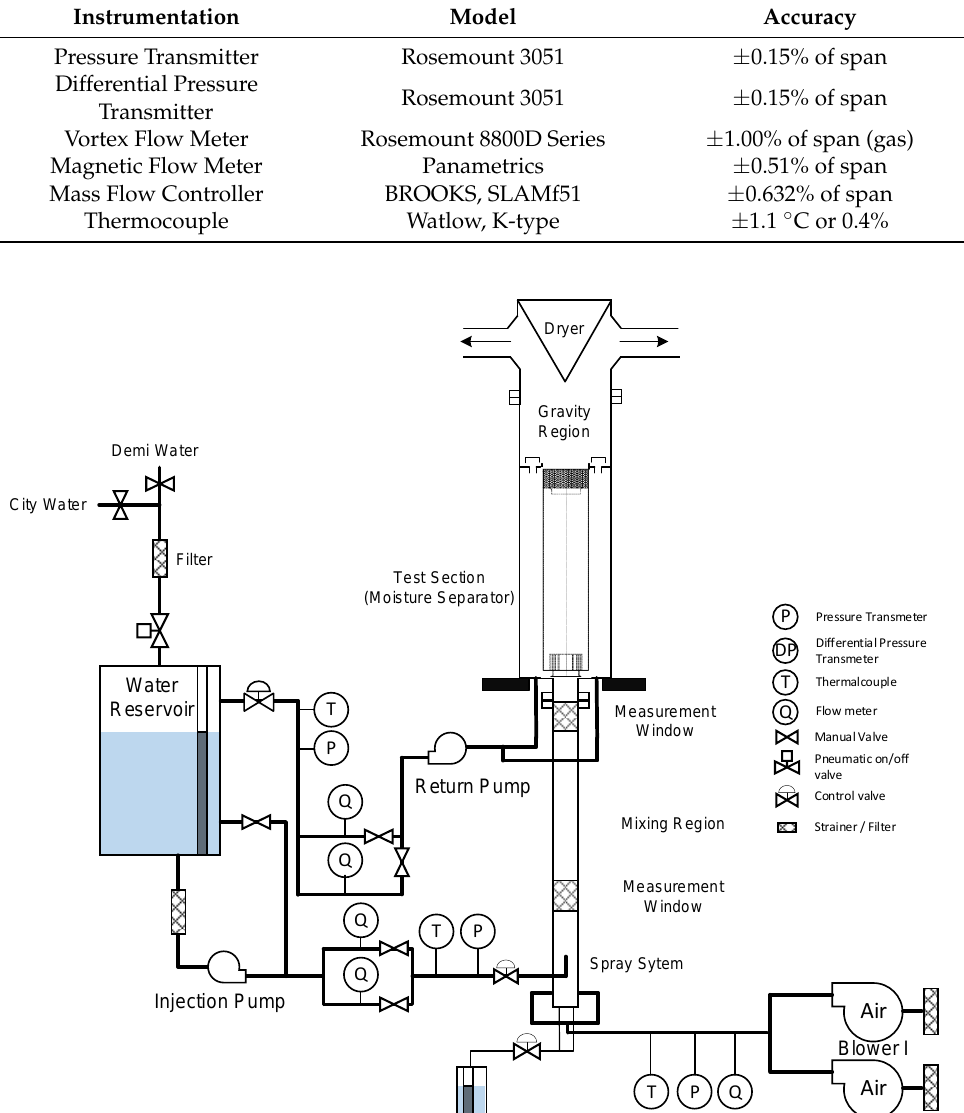
Table 2. Accuracy of instrumentation.